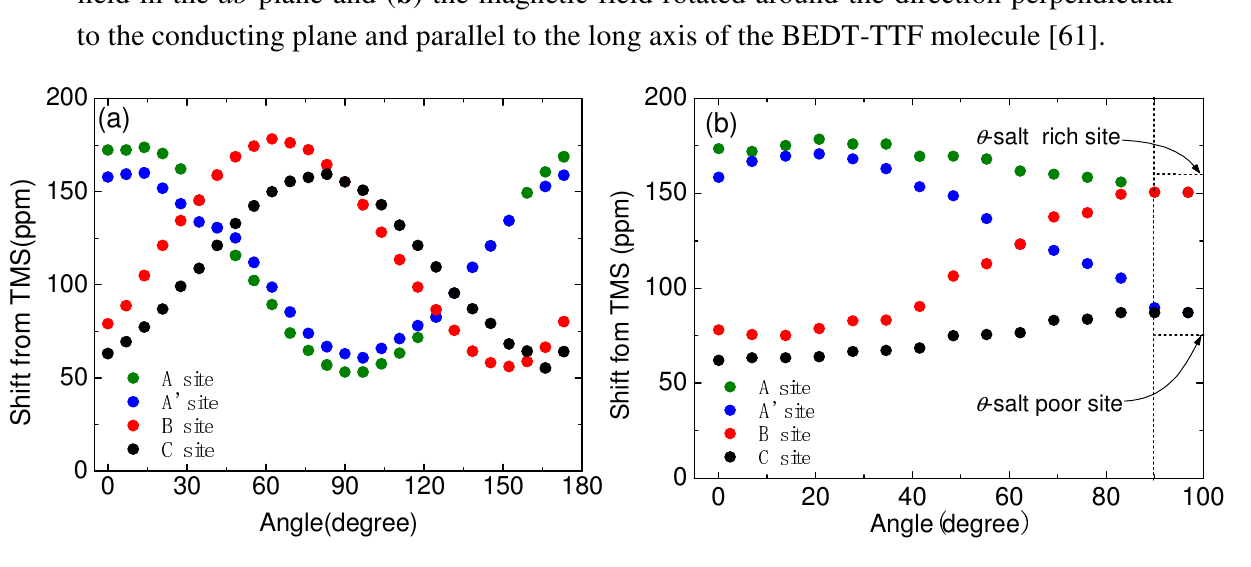
I ( a ) at the magnetic 2 3